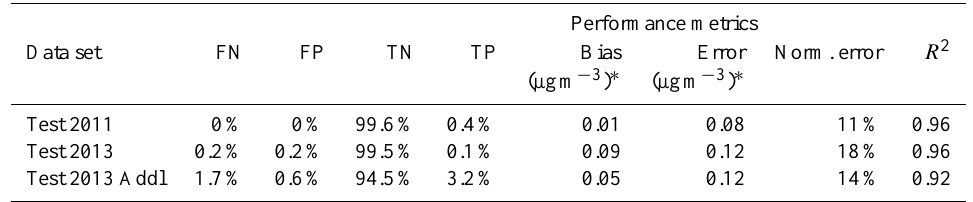
Table 3. FT-IR OC, anticipation of the prediction error per sample. Percentage of ambient samples falling in the FN (false negative), FP (false positive), TN (true negative), and TP (true positive) sectors. Performance metrics of the models that exclude predictions of samples that fall in the FP and TP sectors.